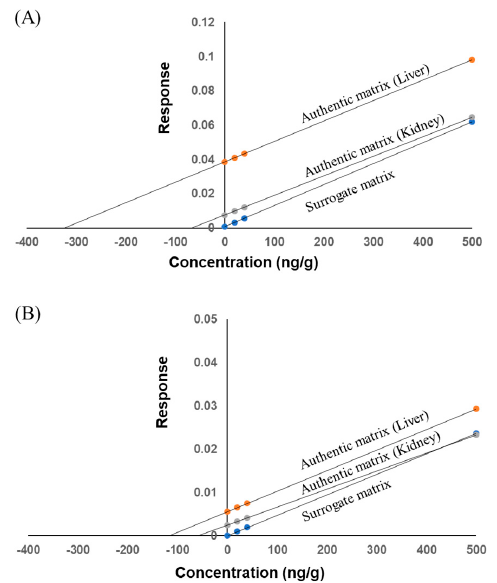
Figure 3. Calibration curves of ( A ) 3 (cid:48) -SL and ( B ) 6 (cid:48) -SL for parallelism assessment in minipig liver and kidney and surrogate matrix. The calibration curves of liver and kidney were constructed by the standard addition